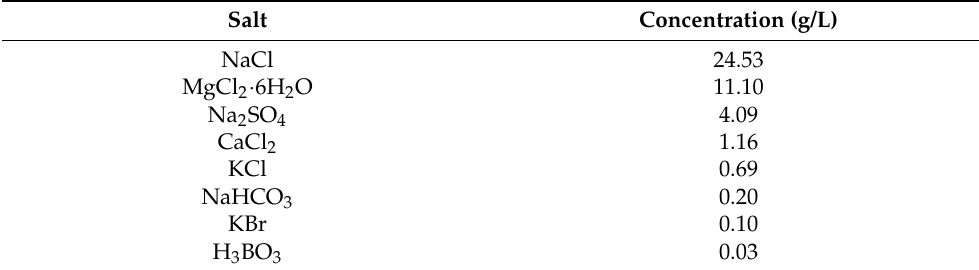
Table 1. Chemical composition of synthetic seawater.